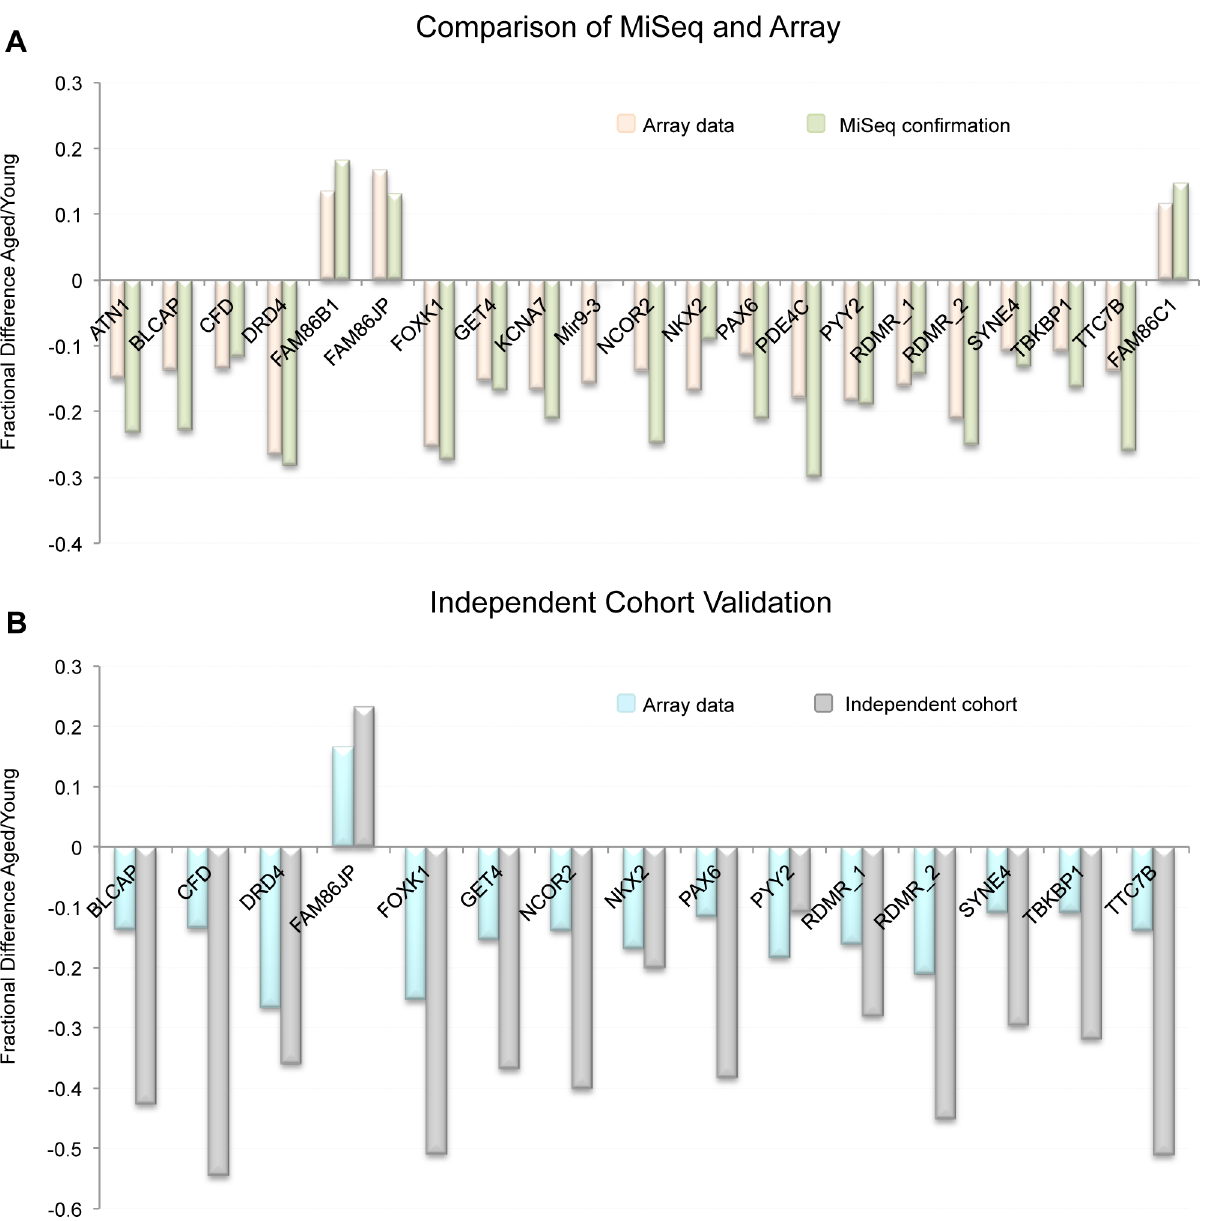
Figure 4. (A) Comparison of MiSeq results to our array results at 21 representative regions. Because beta-values and fraction methylation are generated in a different manner (array vs. sequencing respectively) they are not directly comparable. For this reason we compared the fractional difference for each loci and each technology. This is accomplished by the following equation: fractional difference=(aged value/young value) 2 1. (B) the fractional difference between young and aged samples at 15 selected loci as measured by array in the 17 donor samples as well as in the independent cohort (19 samples from individuals . =45 years of age and 47 samples from individuals , 25 years of age taken from the general population). On average the fractional difference identified in the independent cohort (as measured by sequencing) was approximately 2.2 times greater in magnitude than was identified in the 17 donors.